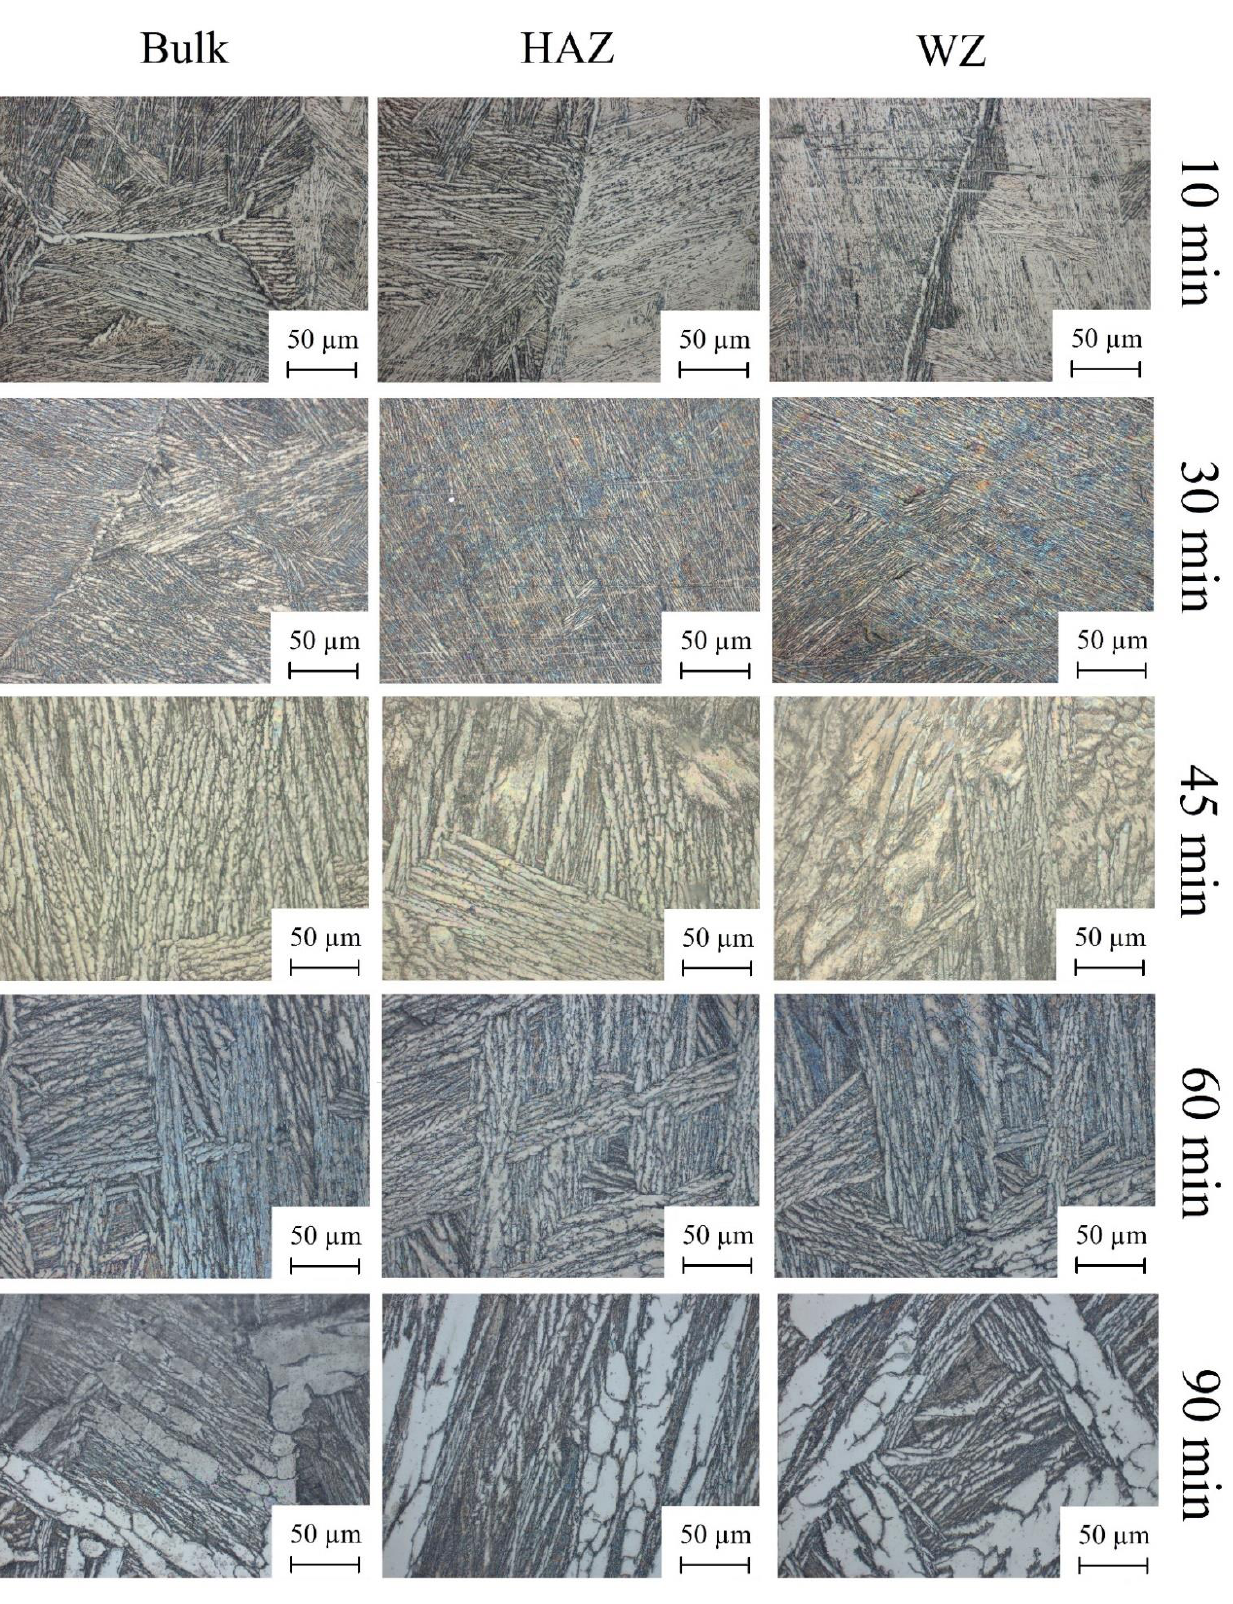
Figure 3. OM images of the cross-section microstructure of Cr-coated LBW samples after air oxidation for 10 – 90 min in WZ, HAZ, and bulk zones.